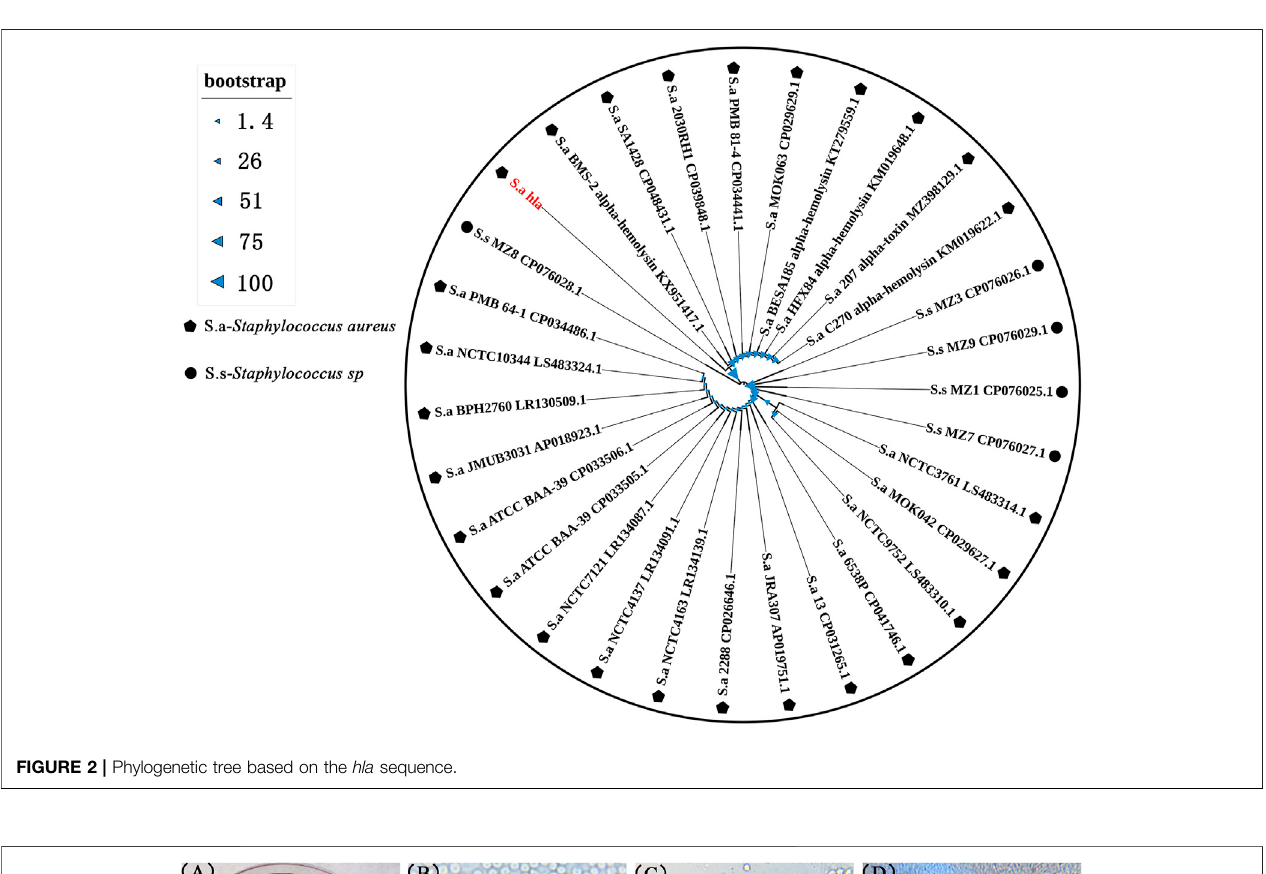
FIGURE 2 | Phylogenetic tree based on the hla sequence.